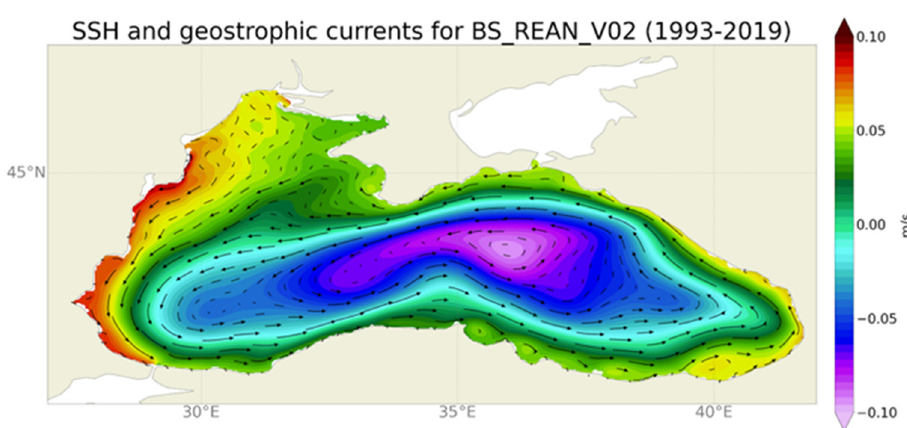
Figure 7. Mean sea-surface height and corresponding mean sea-surface circulation from the BS-PHY MY product evaluated for the period of 1993–2019.